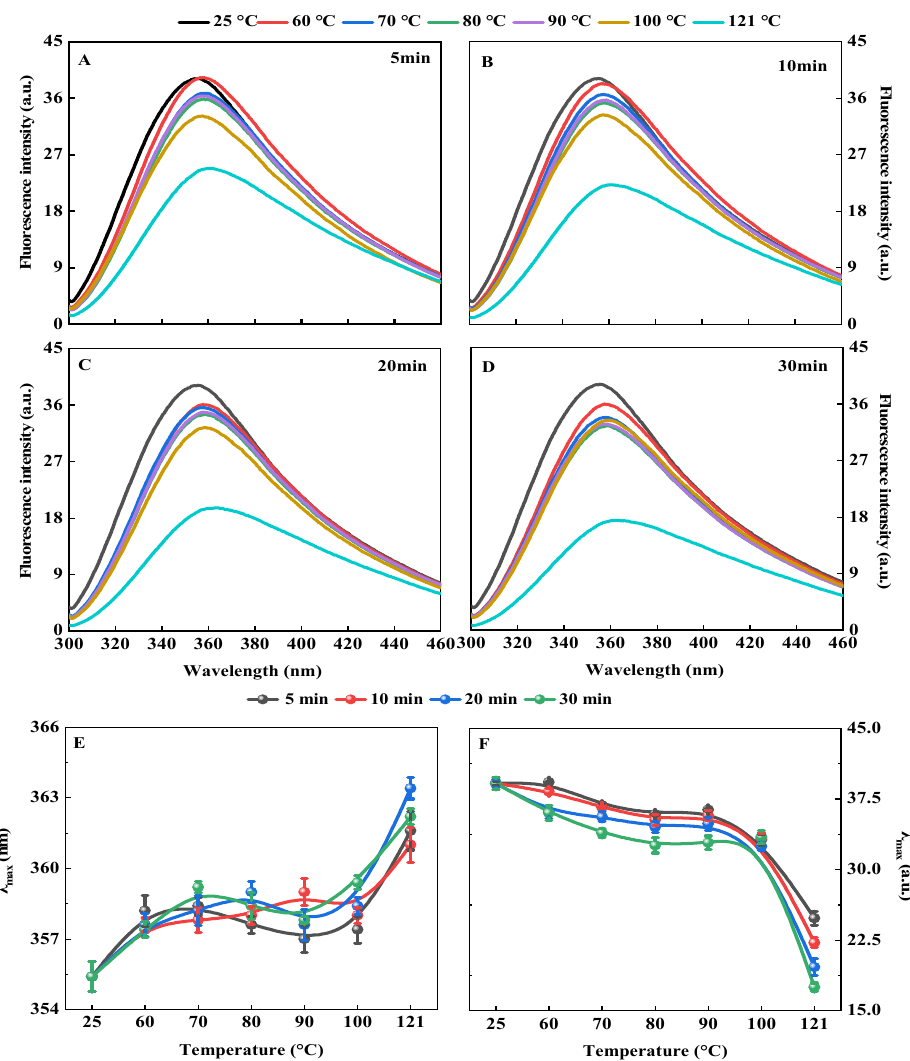
Figure 3. Effects of hydrothermal treatment of 5 min ( A ), 10 min ( B ), 20 min ( C ), and 30 min ( D ) on endogenous fluorescence spectrum, maximum absorption wavelength ( E ), and maximum fluorescence intensity ( F ) of QPI.